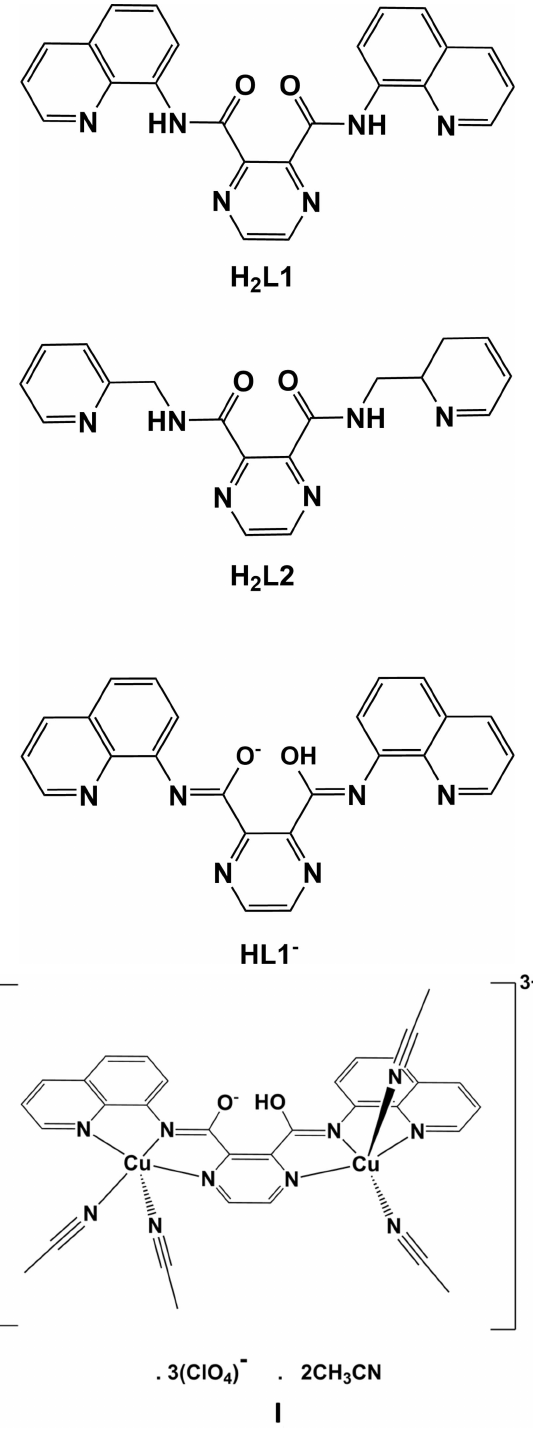
Figure 2 Molecular structure of the cation of complex I , with atom labelling. Displacement ellipsoids are drawn at the 50% probability level. For clarity, the perchlorate anions and the solvate acetonitrile molecules have been omitted. Cati and Stoeckli-Evans (cid:6) C 24 H 16 N 6 O 2 and [Cu 2 (C 24 H 15 N 6 O 2 )(C 2 H 3 N) 4 ](ClO 4 ) 3 333